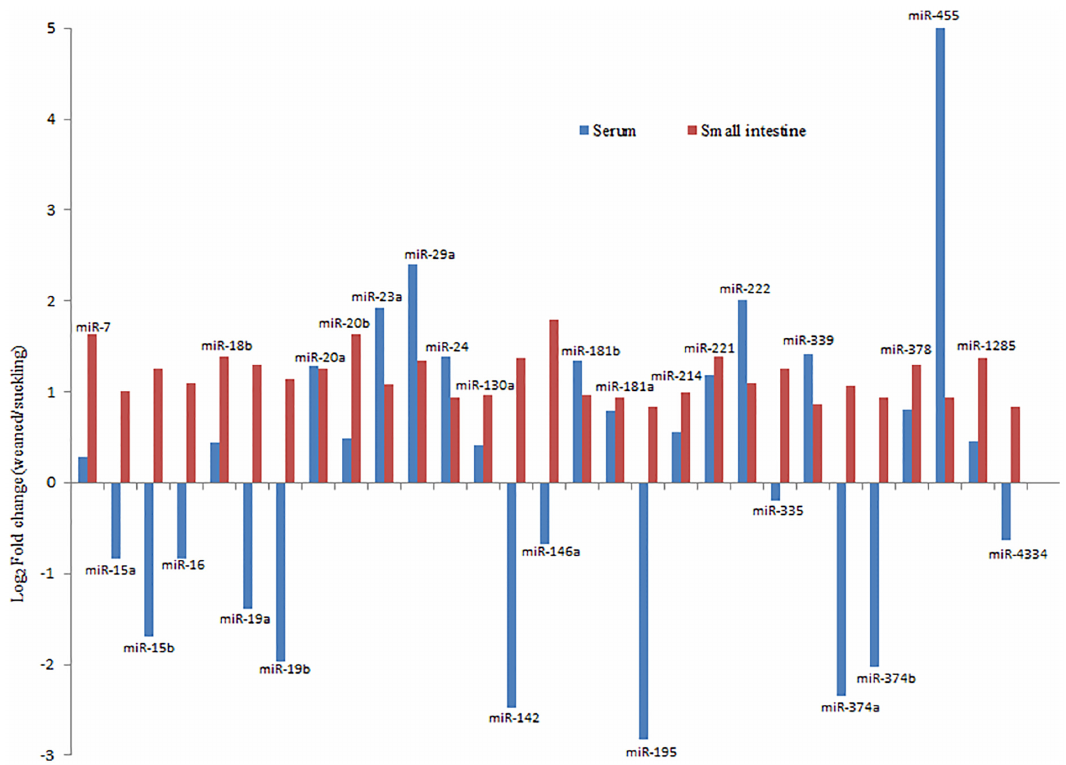
Fig 3. Comparison of all differentially expressed miRNAs (excluding 10 core miRNAs) in serum with those in small intestine.